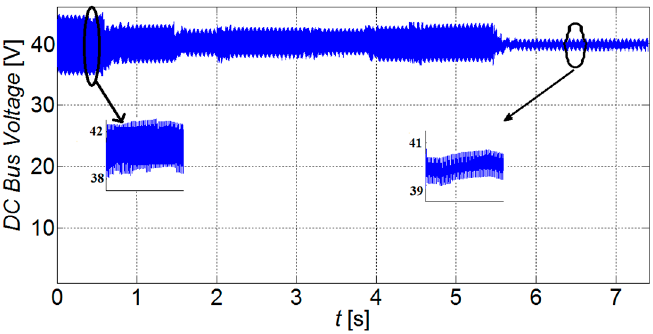
Figure 19 . Automatic search mode DC bus voltage for three parallel converters.